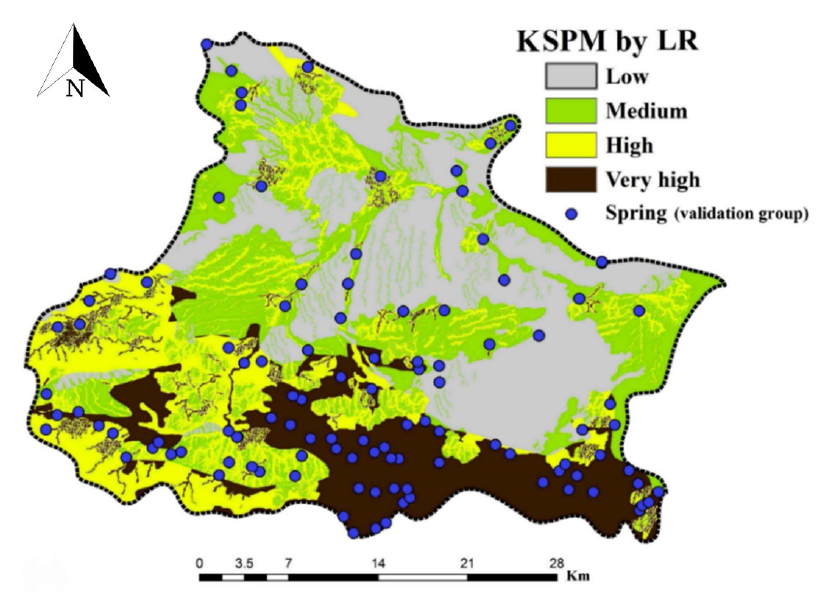
Figure 6. Karst spring potential map produced by the LR modelling.